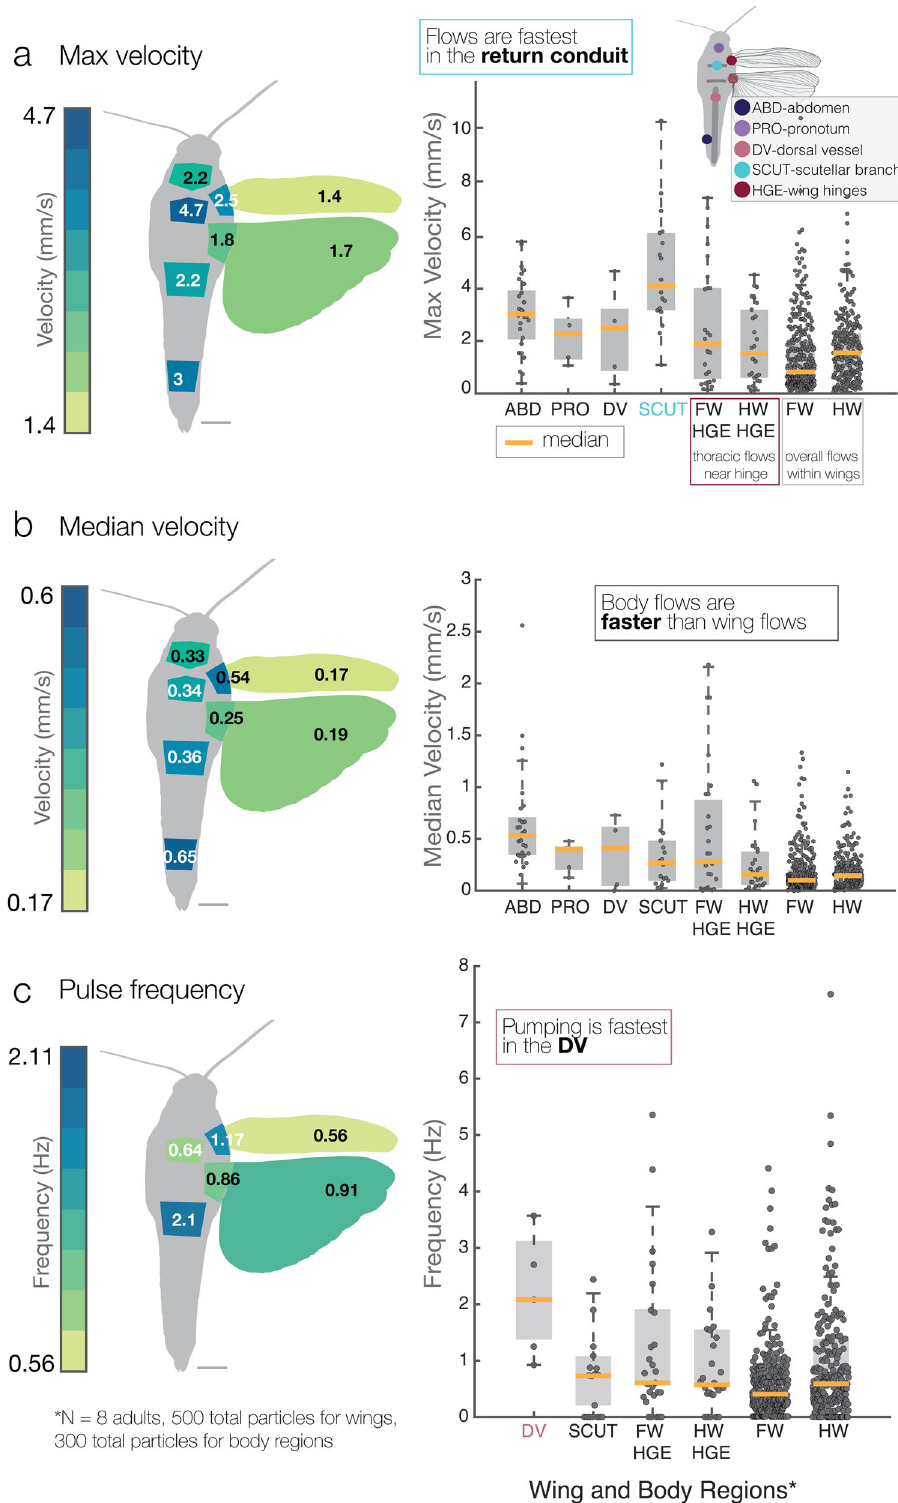
Fig. 5 Comparison of fl ow in the body versus the wings. a – c Averages of the maximum instantaneous particle velocities, instantaneous median velocities, and pulse frequencies across the body and wings, along with box and whisker plots (median in orange) of particle data (see the “ Methods ” section for calculation). In a and b fl ows are faster within the body than in wings. c Average pulse frequency (as calculated in Fig. 4e) shows that pumping is highest in the dorsal vessel at 2.1 Hz, versus the scutellar branch (SCUT) at 0.64 Hz (return conduit for fl ow) and wing areas which have similar frequencies. FW- HGE indicates thoracic fl ows near the hindwing hinge. Scale bar — 5 mm. For each box, the central mark is the median, and the bottom/top edges indicate the 25th and 75th percentiles. Whiskers extend to extreme data points ( n = 8 individual grasshoppers and 500 digitized particles within the wings, 300 particles within the